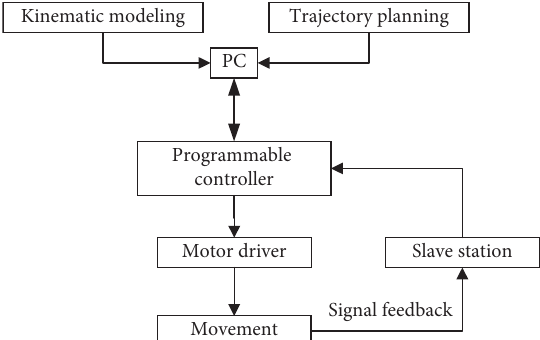
Figure 21: Control schematic diagram of the single-leg